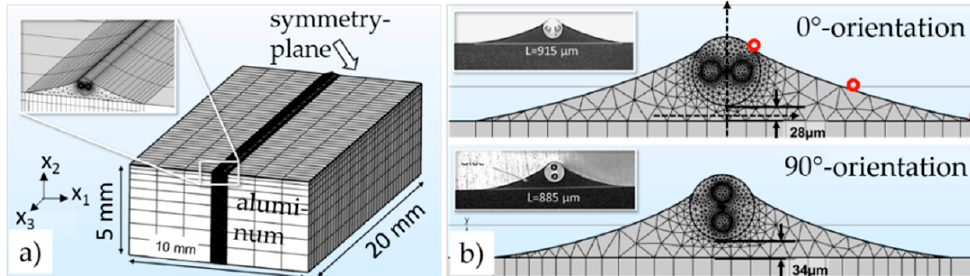
Figure 2. The used mesh and gluing joints for the mechanical three-dimensional finite element method (3D-FEM) simulation: ( a ) An overview of the aluminum specimen, glue, and PM fiber; ( b ) A detailed view of the geometry of the gluing joints. The insets show the metallurgic cross-sections of the glued PM-FBG after curing at 150 °C for one hour.